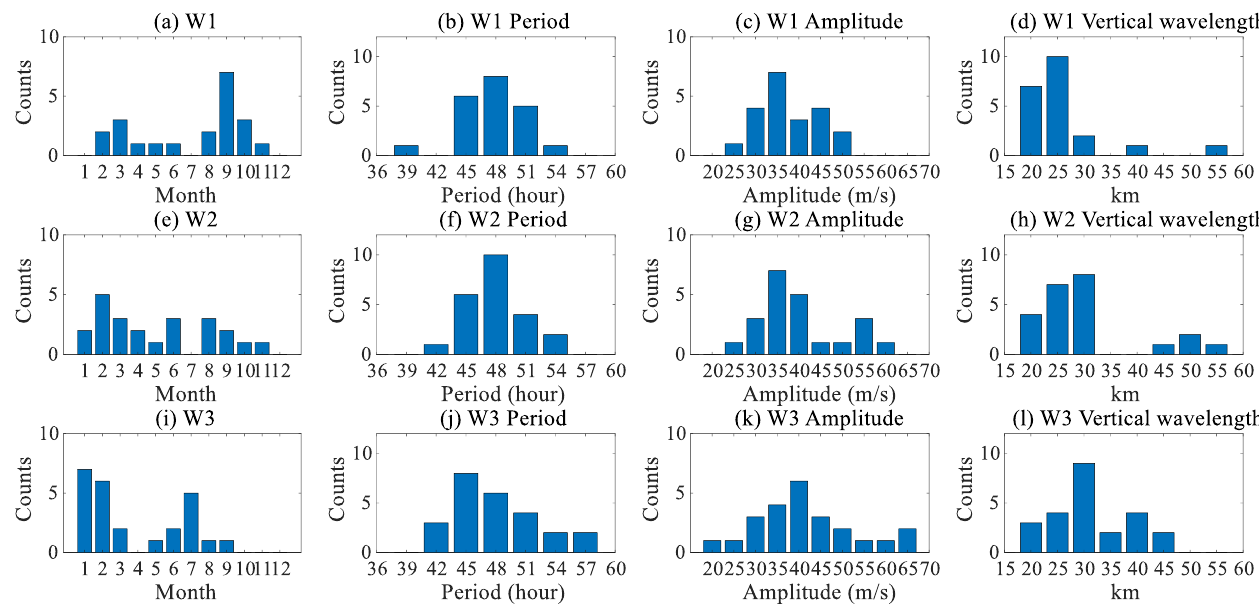
Figure 4. The statistic of ( a ) W1, ( e ) W2, and ( i ) W3 QTDW events over KB from 2003 to 2012. The periods statistic of ( b ) W1, ( f ) W2, and ( j ) W3 QTDW events over KB from 2003 to 2012. The amplitude statistic of ( c ) W1, ( g ) W2, and ( k ) W3 QTDW events over KB from 2003 to 2012. The vertical wavelength statistics of ( d ) W1, ( h ) W2, and ( l ) W3 QTDW events over KB from 2003 to 2012. Figure 4b,f,j display the period statistic of QTDW events with different zonal wavenum- bers. Figure 4b exhibits the distribution results of the periods of QTDWs over KB from 2003 to 2012. The period distribution of W1 waves ranged from 39 to 54 h, and the periods were mainly concentrated between 45 and 51 h, with the most occurring for 48 h. This is also further evidence that the period of QTDWs is approximately 48 h. Figure 4f shows the period statistics of W2 QTDWs at the equator, which is more concentrated than those of W1 waves. The period distribution of W2 waves is between 42 and 54 h, which is similar to that of the W1 waves. Furthermore, the period of W2 waves is mainly concentrated between 45 and 51 h with most appearing for 48 h. The period statistics of W3 QTDWs are exhibited in Figure 4j and are different from those of W1 and W2 waves. Figure 4j shows periods ranging from 42 h to 57 h, with a maximum of 45 h. Palo, Roble, Hagan and space [20] observe that the periods of the QTDWs were concentrated to approximately 48 h in summer in the Southern Hemisphere, while the periods and the time of occurrence